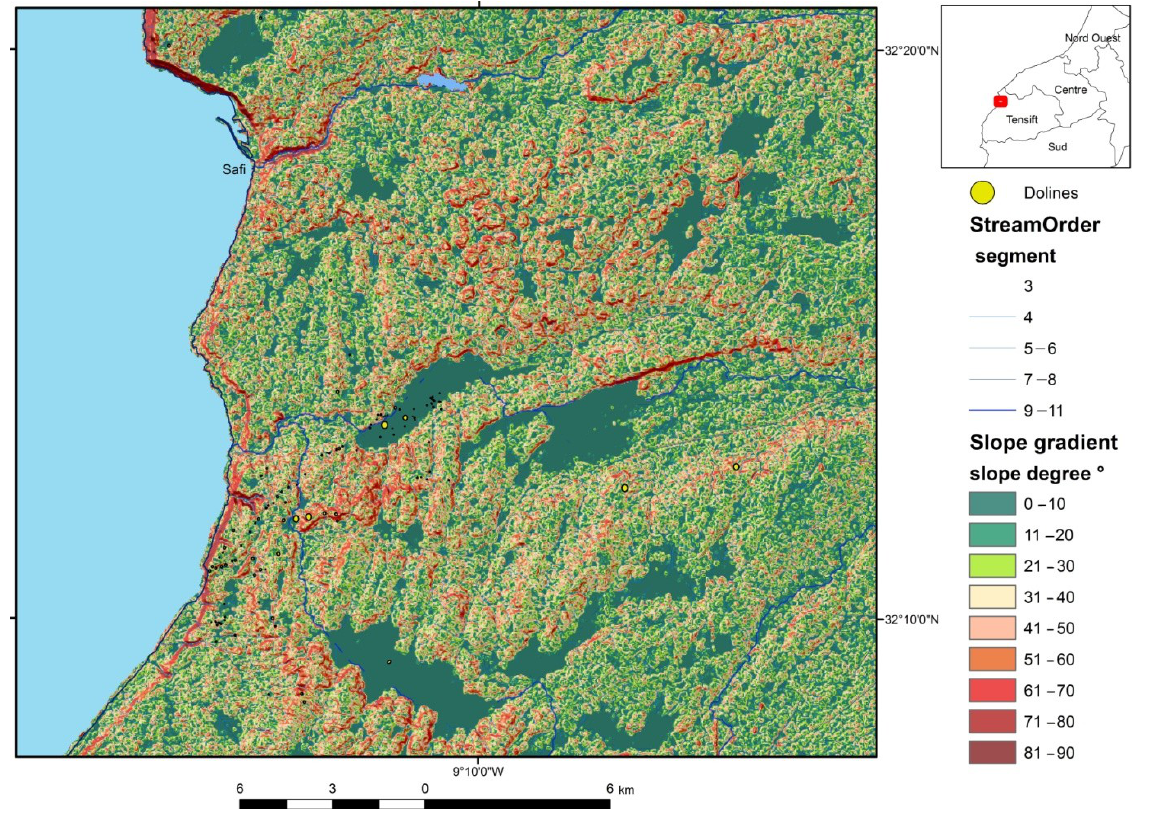
Figure 5. Slope map of the investigation area.